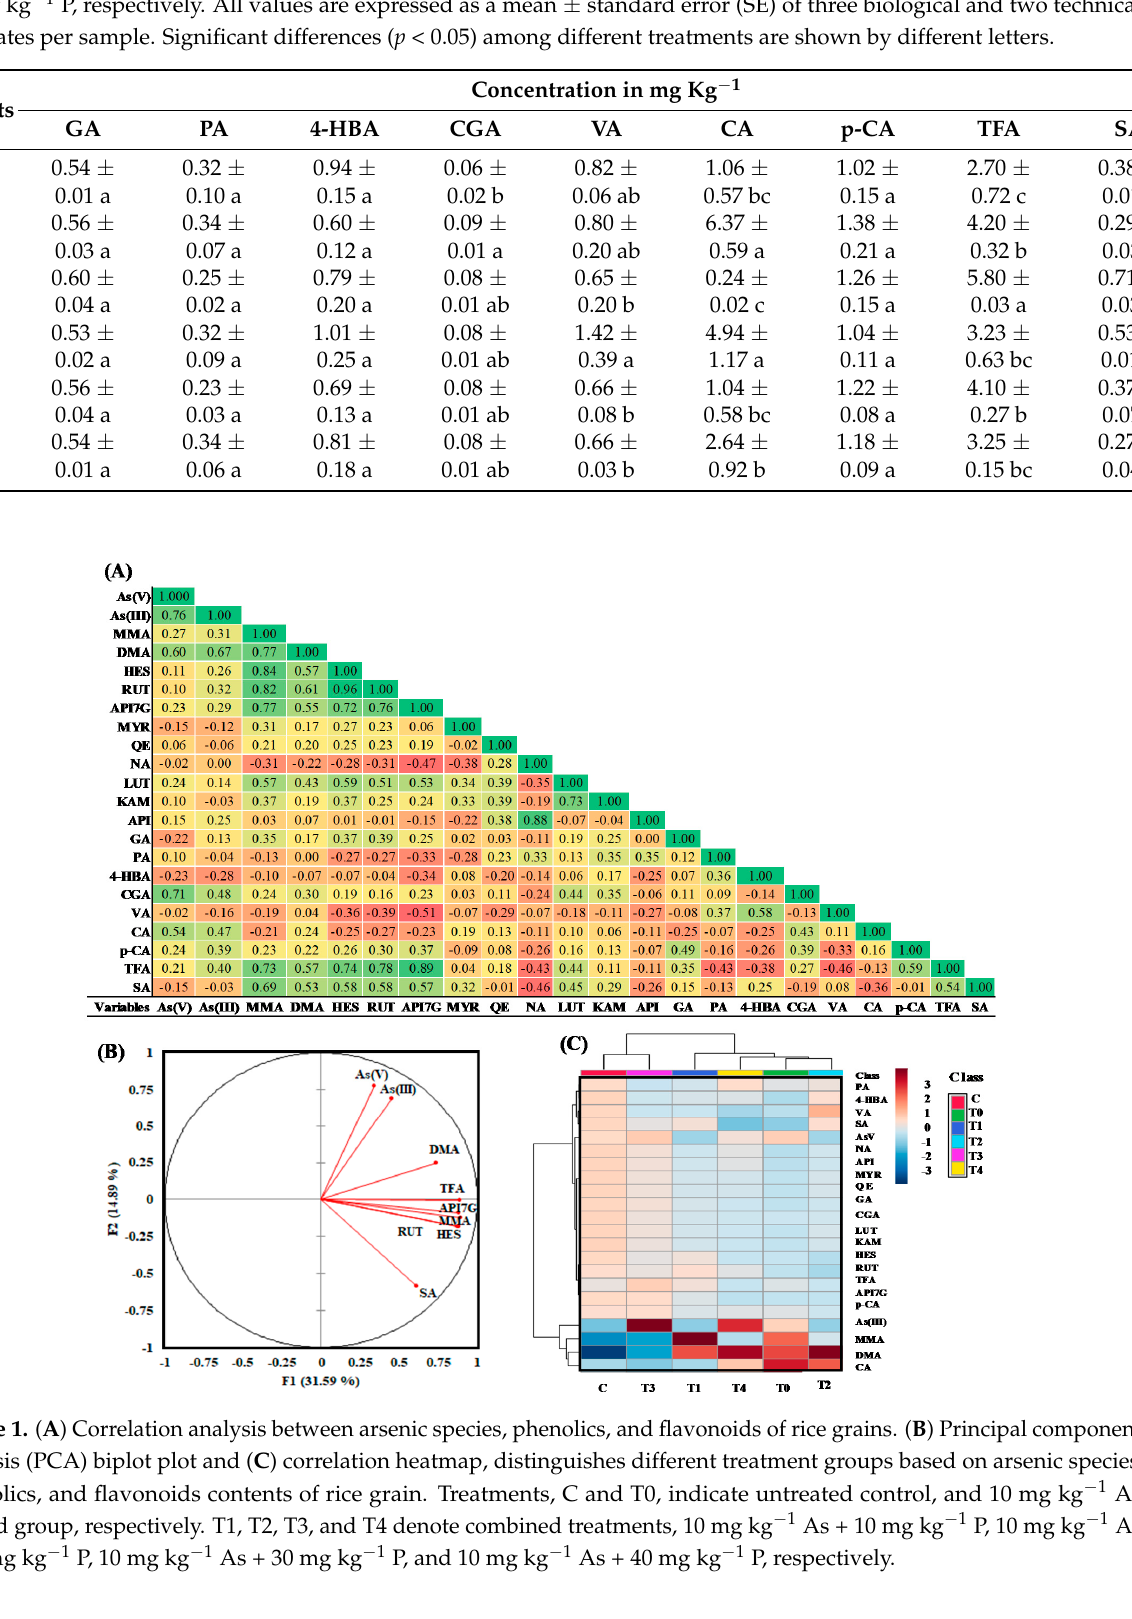
Table 3. Phenolic acid profiles of rice grain samples after exposure of different Arsenic (As) and combined As and orthphosphate (P) treatments. Treatments, C and T0, indicate untreated control, and 10 mg kg − 1 As treated group, respectively. The base soil As content in control group was 35 µ g kg − 1 . T1, T2, T3, and T4 denote combined treatments,